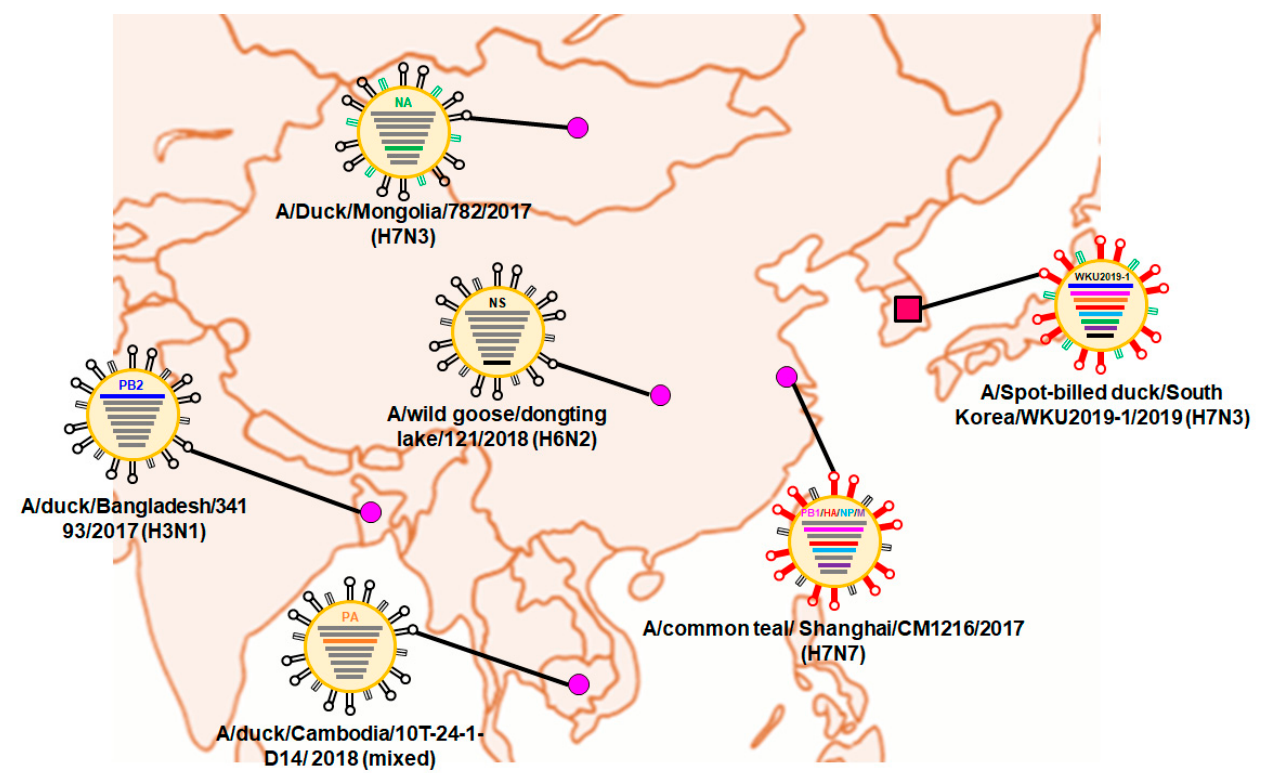
Figure 1. ( A – H ) Phylogenetic analysis of H7N3 (WKU2019-1) for eight gene segments. ( A ) PB2, ( B ) PB2, ( C ) PA, ( D ) HA, ( E ) NP, ( F ) NA, ( G ) M, ( H ) NS. (PB—polymerase basic protein; NP—nucleoprotein; HA—hemagglutinin; PA—